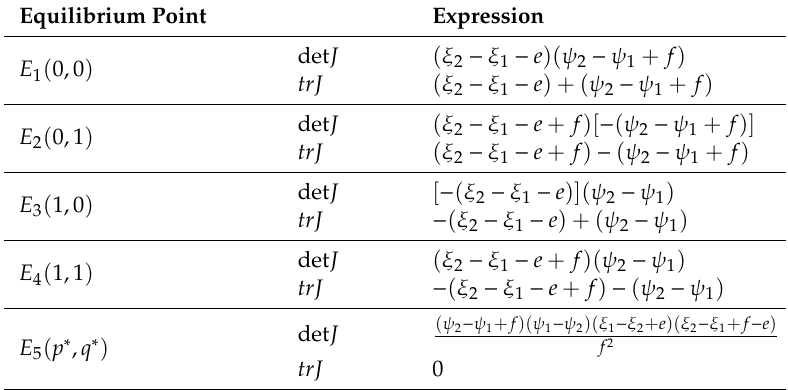
Table 3. All parameters.